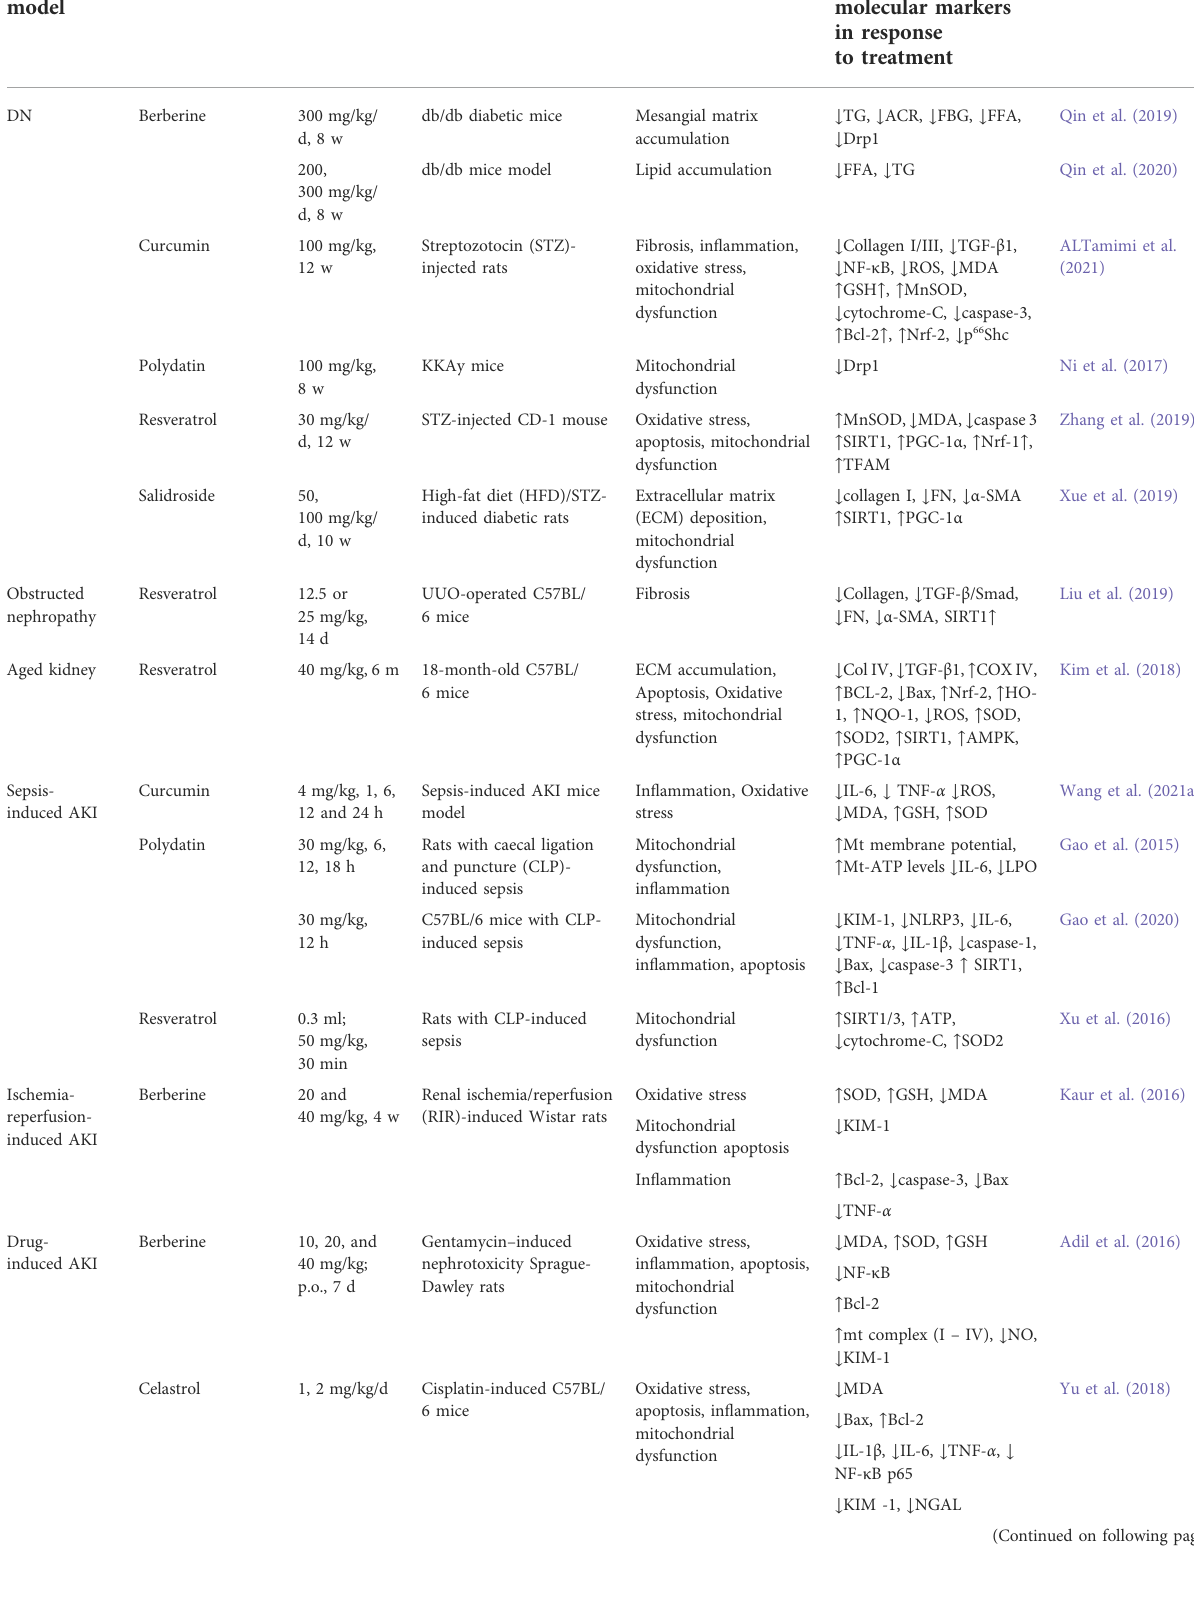
TABLE 1 Kidney protective effects are provided by phytochemicals targeting mitochondrial fi tness in animal